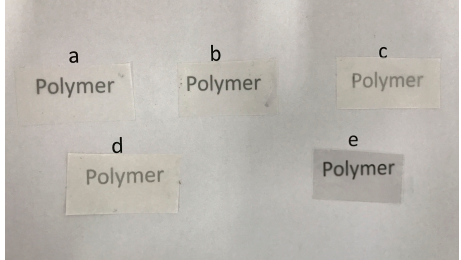
Figure 2. The visual properties of: ( a ) PLA/Ti1%, ( b ) PLA/Ti5%, ( c ) PLA/Ti1%/Ag, ( d ) PLA/Ti5%/Ag, and ( e ) PLA.